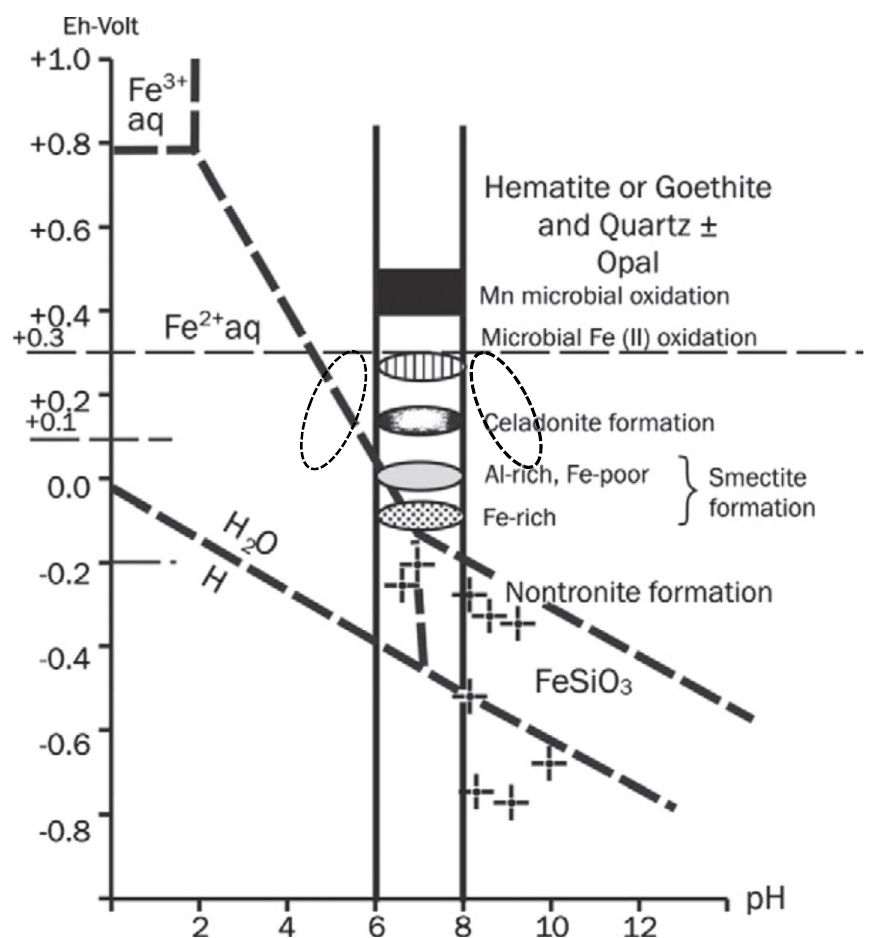
Figure 3. Estimated formation conditions of the clay minerals in the black shale-hosted Mn carbonate ore deposit (Úrkút) zone of microbial Fe(II) oxidation (+0.3 V Eh using recent analogs) [37,77,78], and the results of nontronite synthesis laboratory experiments (by dashed lines) [23,24]. Note: In general, oxidizing conditions mean high oxygen concentration (high Eh values up to +0.4 V), while reduced conditions reveal a lack of oxygen (low Eh down to − 0.2 V). Eh estimation is based on [33,79]. Changing diagenetic conditions are signed by black dotted circle. Modified after [17] (with permission of Elsevier Publishing House).